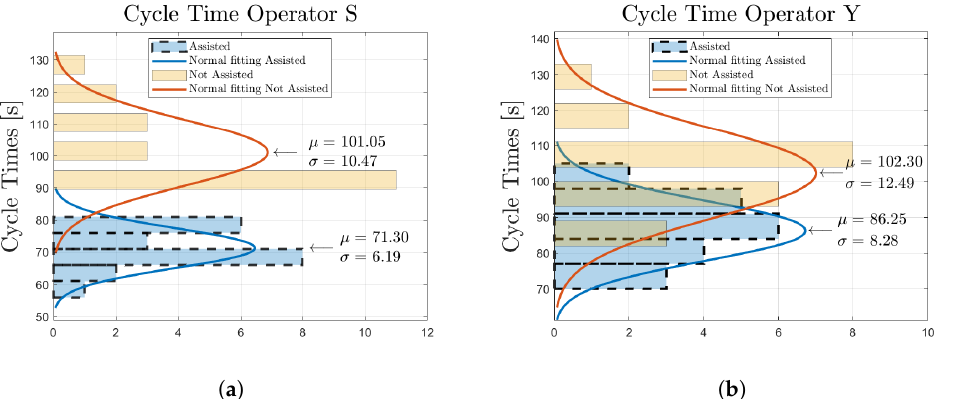
Figure 12. Assembly cycle times distributions for Assisted and Not Assisted cases with mean and standard deviation. ( a ) Operator S. ( b ) Operator Y.